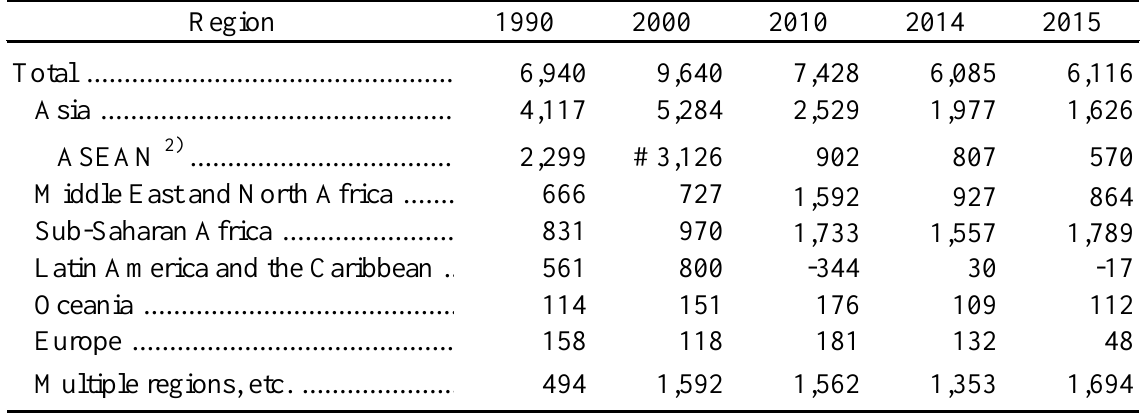
Table 11.8 Regional Distribution of Bilateral ODA 1)